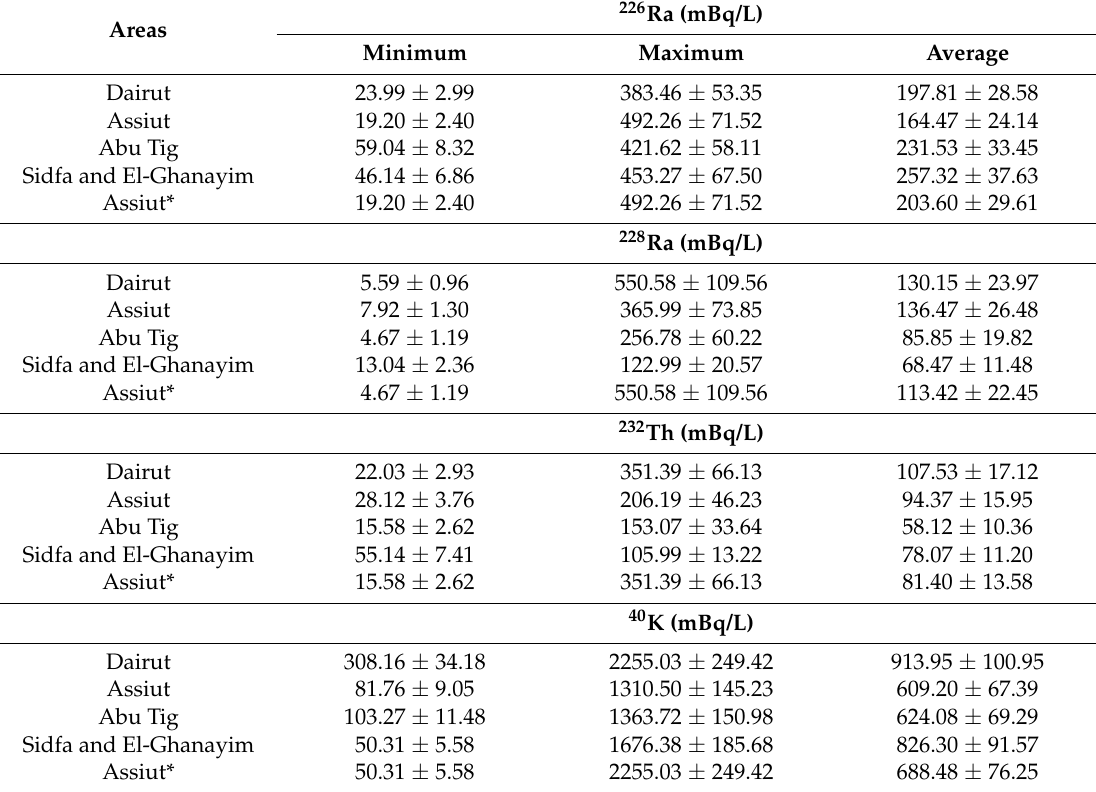
Table 2. The ranges and average values of 226 Ra, 228 Ra, 232 Th, and 40 K activity concentrations for water